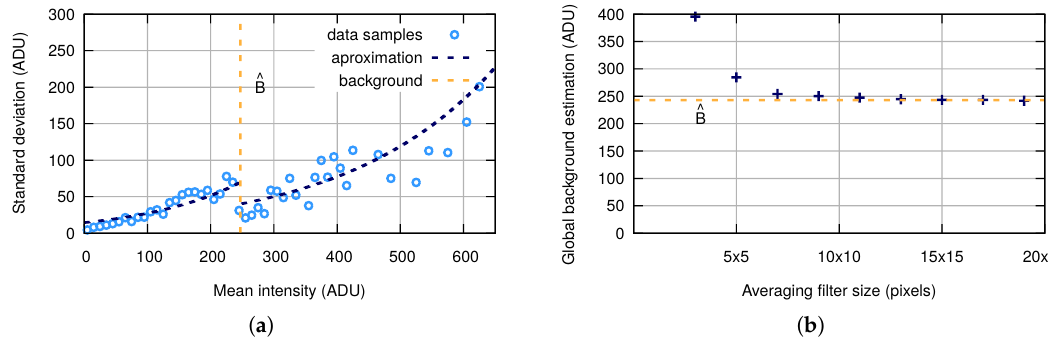
Figure 9. ( a ) The model of the statistical characteristic dependency. ( b ) Size of the averaging filter for the global background estimation.